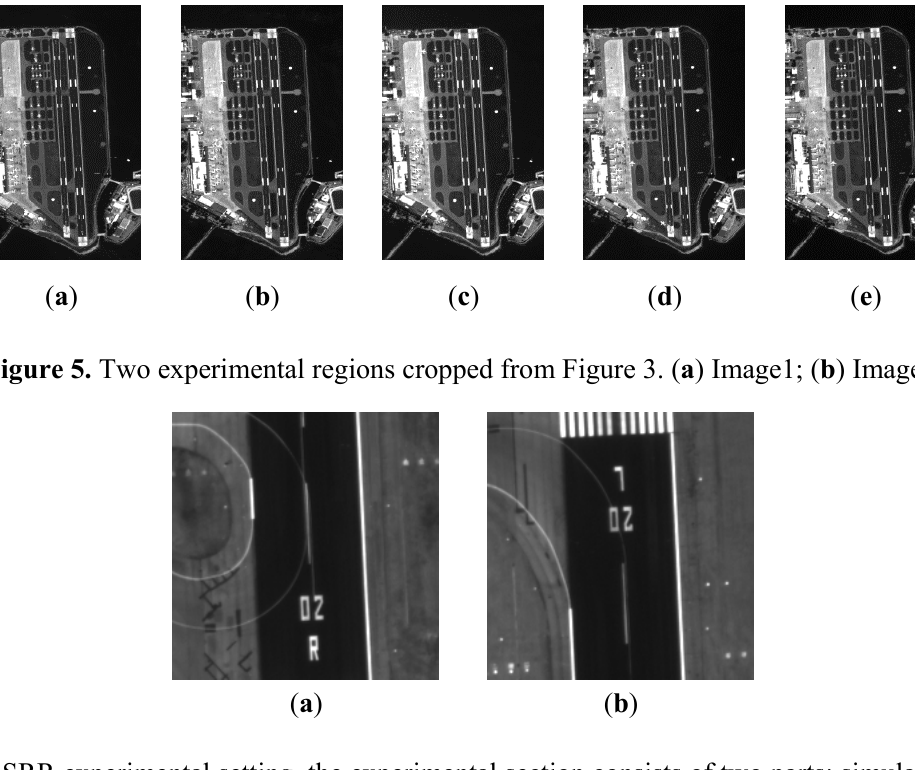
Figure 4. Band 1 of the multi-angle WorldView-2 multispectral imagery. From ( a ) to ( e ): 81.4° in the forward direction, 59.8° and 44.6° in the backward direction, and 44.7° and 56.0° in the forward direction.